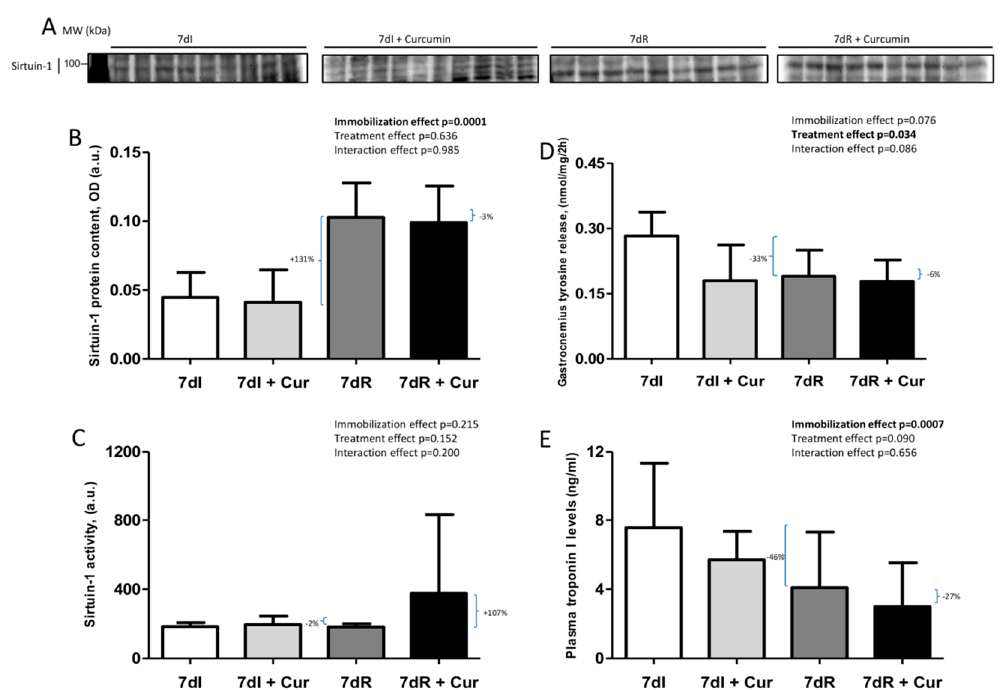
Figure 4. ( A ) Representative immunoblots of sirtuin-1 protein in the gastrocnemius muscle of all study groups of mice. Definition of abbreviations: MW, molecular weight; kDa, kilodalton; I, immobilization; R, recovery. ( B ) Mean values and standard deviation of sirtuin-1 protein content in the gastrocnemius muscle of the di ff erent study groups of mice, as measured by optical densities in arbitrary units (OD, a.u.). Definition of abbreviations: OD, optical densities; a.u., arbitrary units; I, immobilization; R, recovery; Cur, curcumin. The statistical analyses (two-way ANOVA test) of the e ff ect of immobilization, treatment and interaction e ff ects, are also indicated as actual P values for each variable. The percentage of change between: 1) 7dR and 7dI and 2) 7dR + Curcumin and 7dR are also indicated for each variable. ( C ) Mean values and standard deviation of sirtuin-1 activity levels in the gastrocnemius muscle of the di ff erent study groups of mice, as measured by fluorescence in arbitrary units (a.u.). Definition of abbreviations: a.u., arbitrary units; I, immobilization; R, recovery; Cur, curcumin. The statistical analyses (two-way ANOVA test) of the e ff ect of immobilization, treatment and interaction e ff ects, are also indicated as actual P values for each variable. The percentage of change between: 1) 7dR and 7dI and 2) 7dR + Curcumin and 7dR are also indicated for each variable. ( D ) Mean values and standard deviation of the variable tyrosine release (nmol / mg / 2 h) of the gastrocnemius muscle of the di ff erent study groups of mice. Definition of abbreviations: nmol, nanomol; mg, milligram; h, hour; I, immobilization; R, recovery; Cur, curcumin. The statistical analyses (two-way ANOVA test) of the e ff ect of immobilization, treatment and interaction e ff ects, are also indicated as actual P values for each variable. The percentage of change between: 1) 7dR and 7dI and 2) 7dR + Curcumin and 7dR are also indicated for each variable. ( E ) Mean values and standard deviation of the variable plasma troponin-I (ng / ml) of the gastrocnemius muscle of the di ff erent study groups of mice. Definition of abbreviations: ng, nanogram; ml, milliliter; h, hour; I, immobilization; R, recovery; Cur, curcumin. The statistical analyses (two-way ANOVA test) of the e ff ect of immobilization, treatment and interaction e ff ects, are also indicated as actual P values for each variable. The percentage of change between: 1) 7dR and 7dI and 2) 7dR + Curcumin and 7dR are also indicated for each